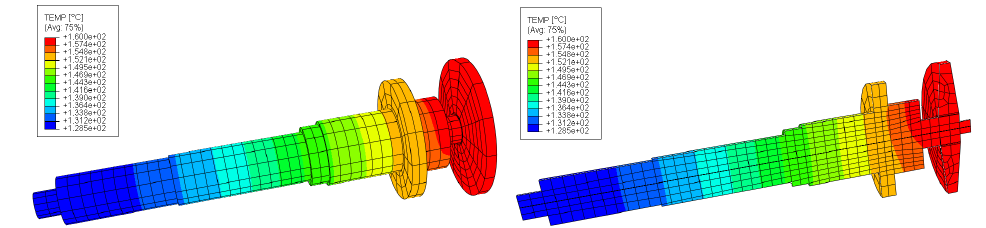
Figure 3: The temperature distribution on the micro-turbine